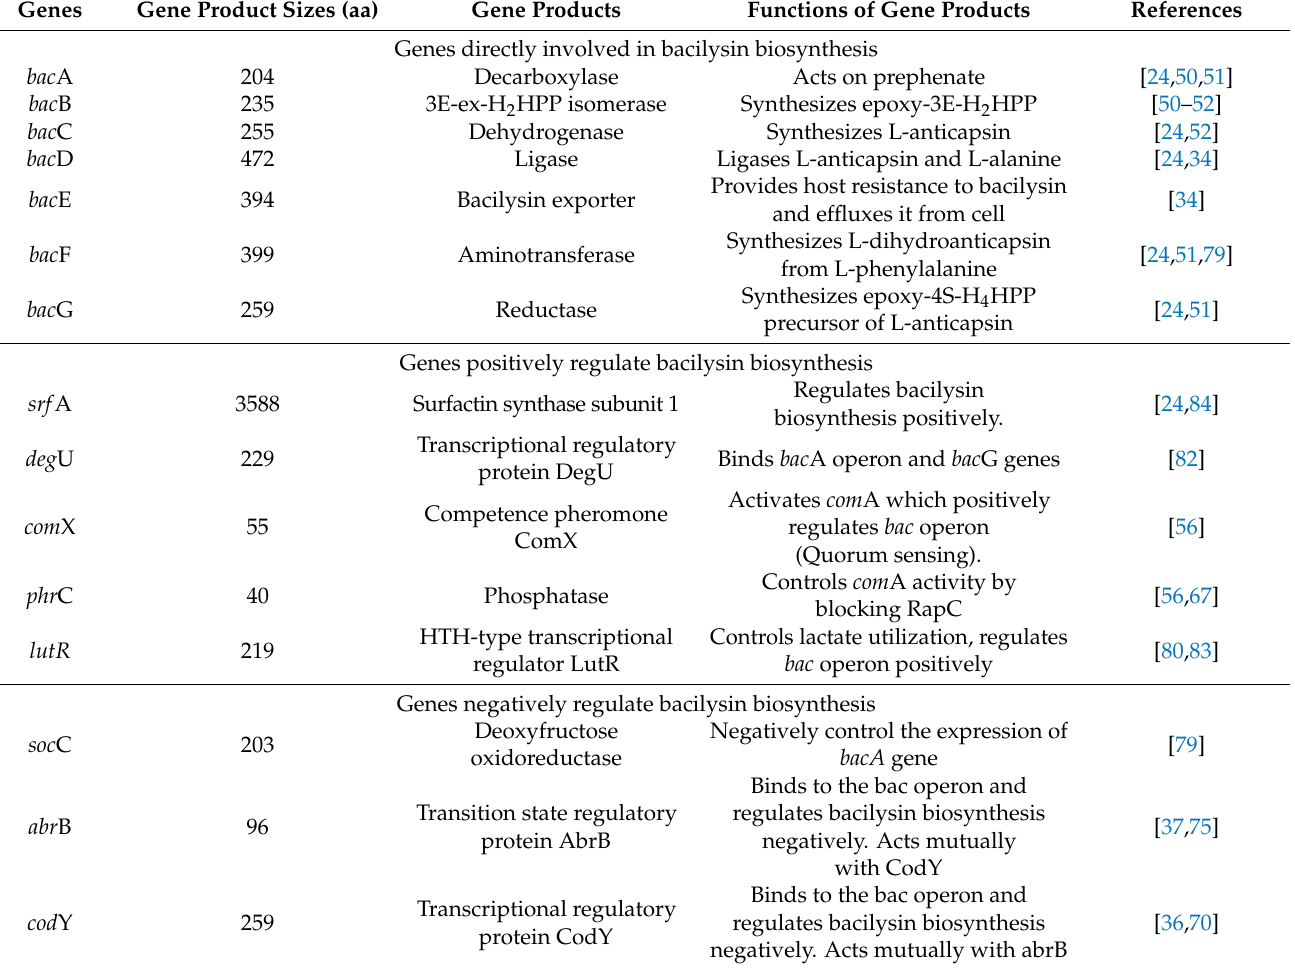
Table 1. Genes involved in bacilysin biosynthesis and its